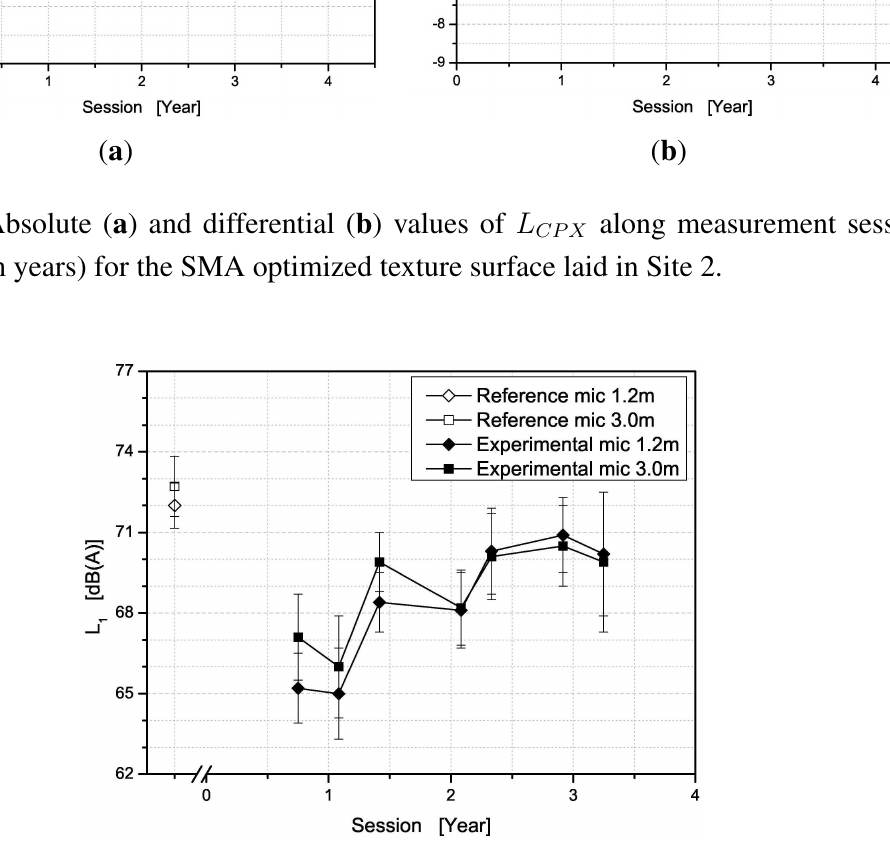
Figure 7. Time evolution of SPB values in Site 2. In white ante-operam